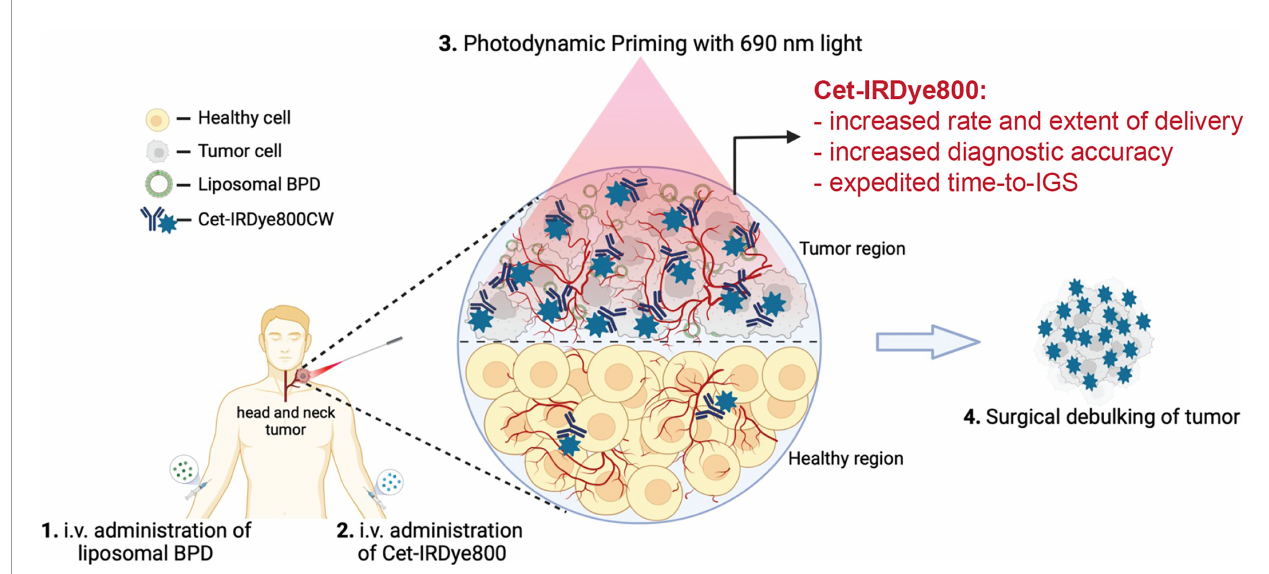
FIGURE 1 | Conceptual Representation of the proposed Photodynamic Image-Guided Surgery Approach. Photodynamic Priming of the tumor microenvironment enhances the tumor delivery of Cet-IRDye800 and its accuracy in detecting tumor tissue. This approach is proposed to assist in the image-guided surgical debulking of head and neck tumors, amongst others. This Figure was created from Biorender.com using an Academic